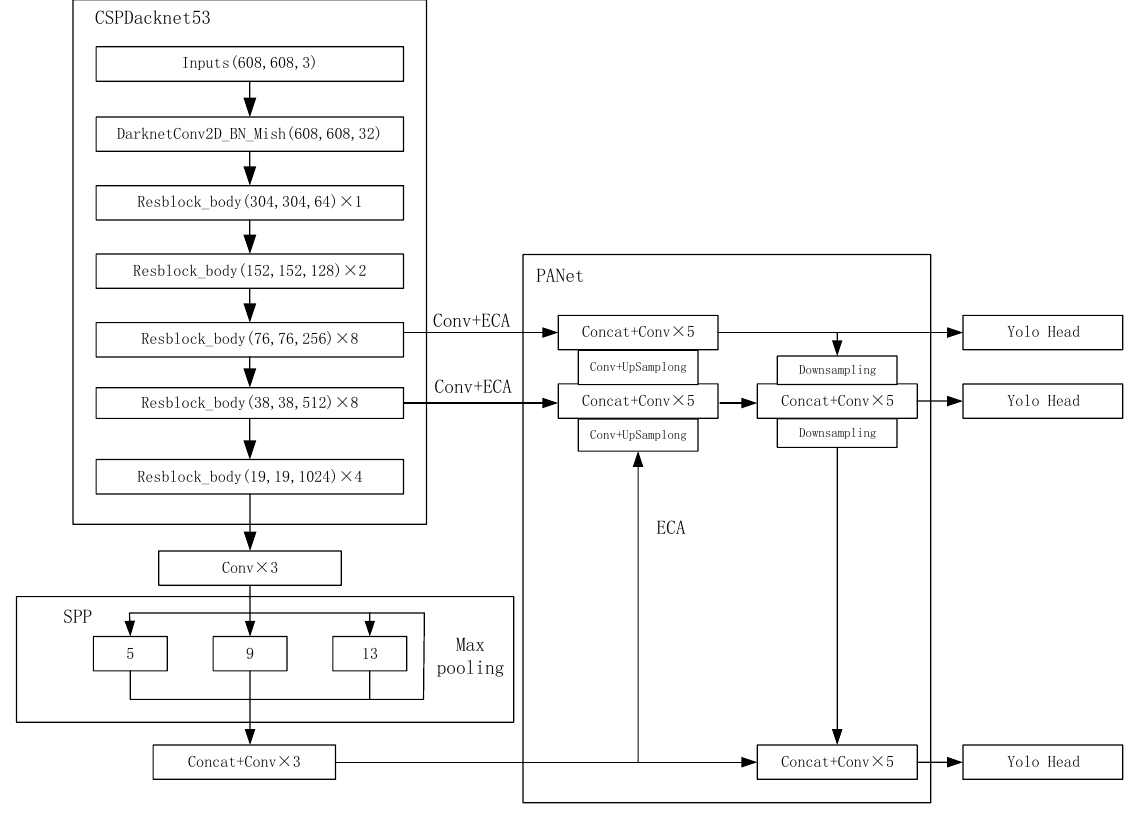
Figure 2. The YOLOV4 model with ECA.